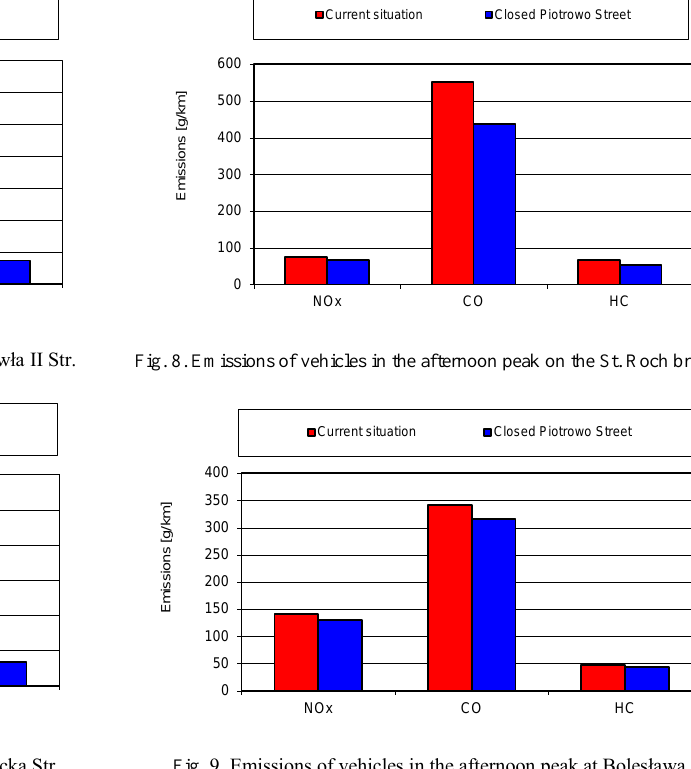
Fig. 7. Emissions of vehicles in the afternoon peak at Kórnicka Str.